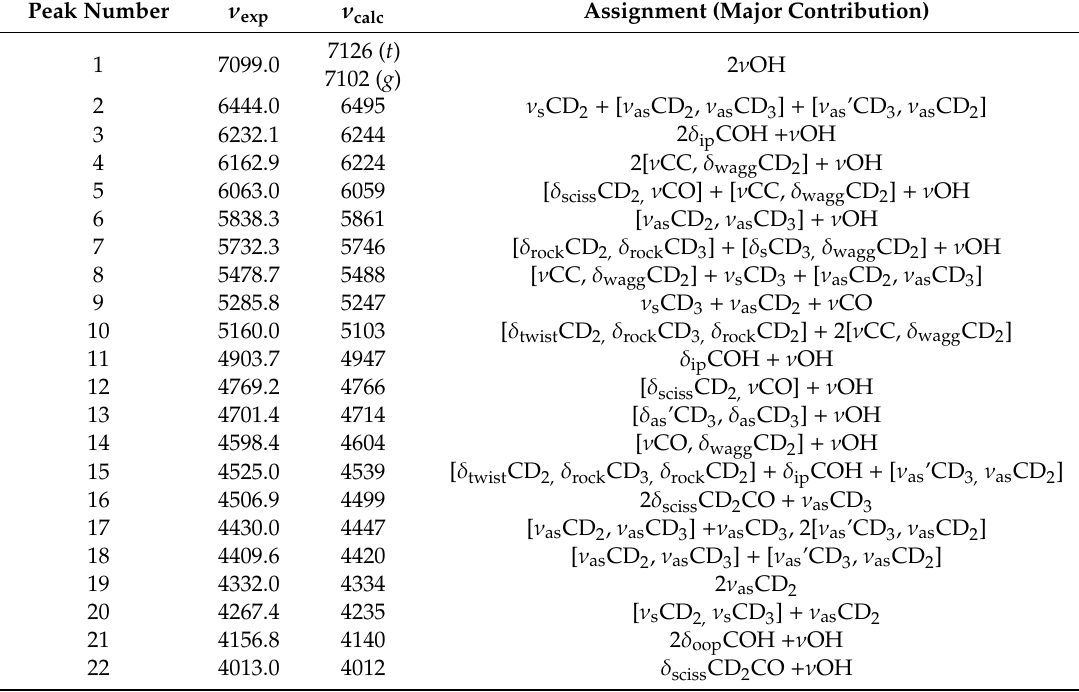
Band assignments in NIR spectra of CD 3 CD 2 OH based on GVPT2 // B2PLYP-GD3BJ / def2-TZVP // CPCM calculations. Band numbering corresponds to that presented in Figure 6A.